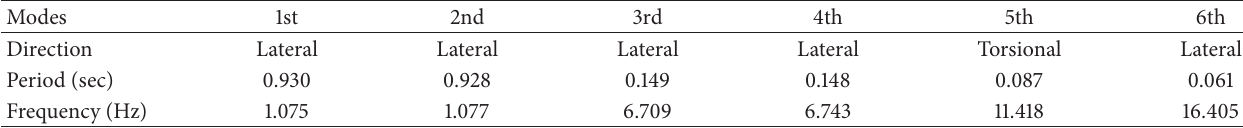
Table 3: The first six calculated natural periods and frequencies after seismic strengthening with